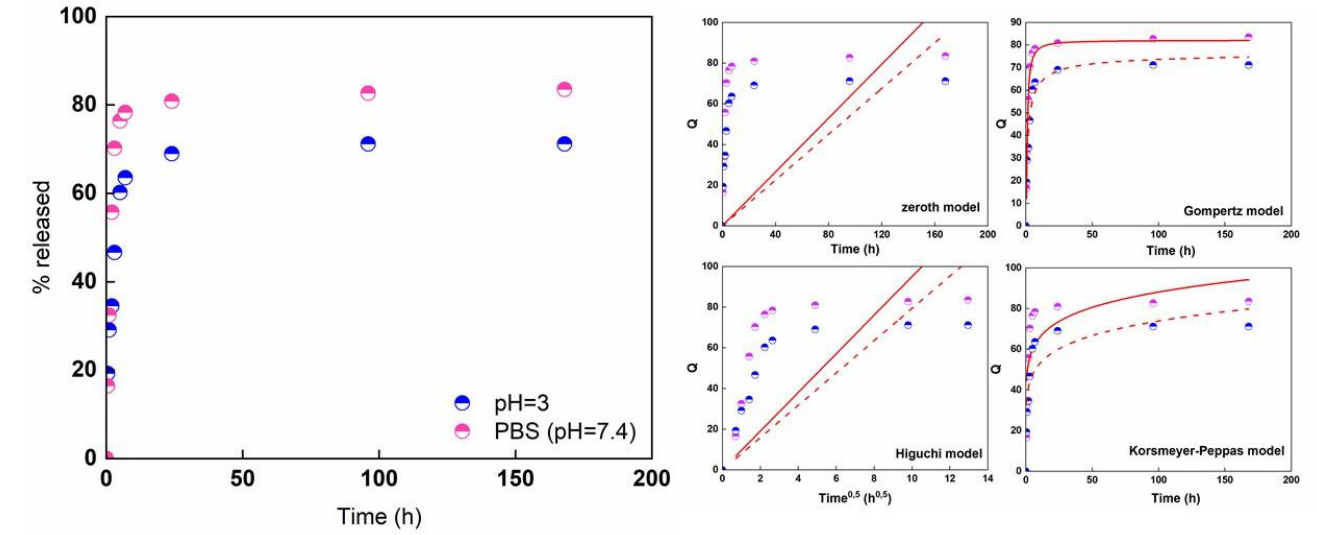
Figure 7. Release data of quercetin from electrospun systems in different media.